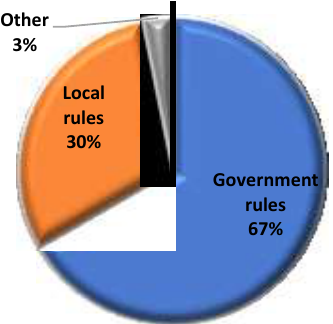
Figure 7. The Need for Local Community rules (Source: Research Data, 2019)